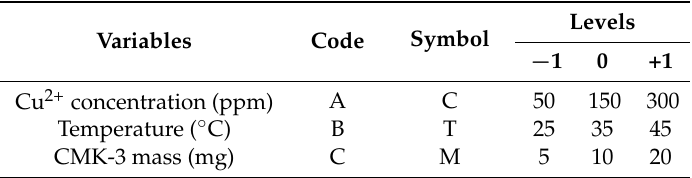
Table 1. The levels of independent